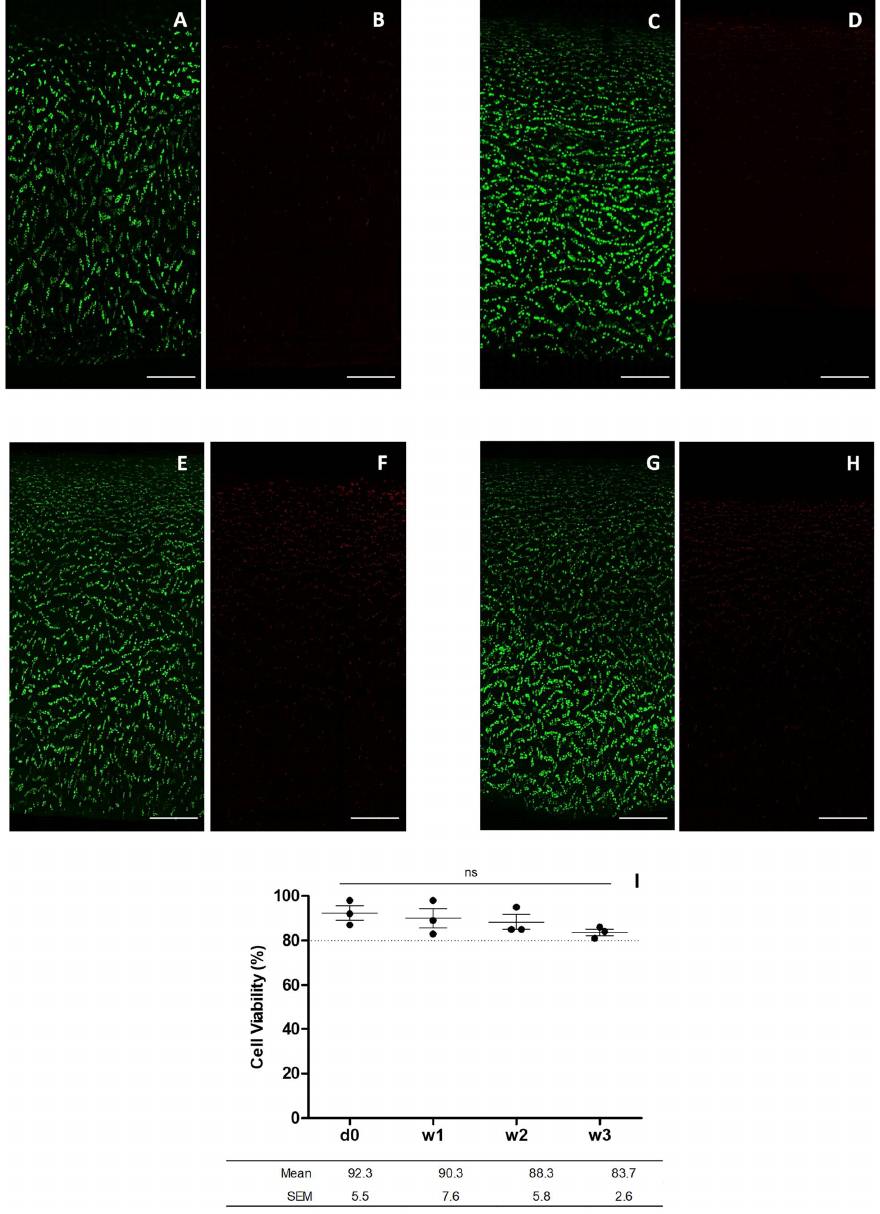
Figure 5. Images for chondrocyte viability obtained by confocal microscopy after incubation with calcein AM and 7-AAD. The images show the cell viability at day 0 ( A , B ), week 1 ( C , D ), week 2 ( E , F ), and week 3 ( G , H ) (scale bar corresponds to 100 µm) and cell viability of cartilage preserved at day 0, and 1, 2 and 3 weeks plotted from data obtained from confocal fluorescence microscopy ( I ). Statistical test: results are shown as mean ± SEM (n = 3) after performing non-parametric ANOVA followed by Dunnett’s post hoc test. Differences between results are considered non-statistically significant